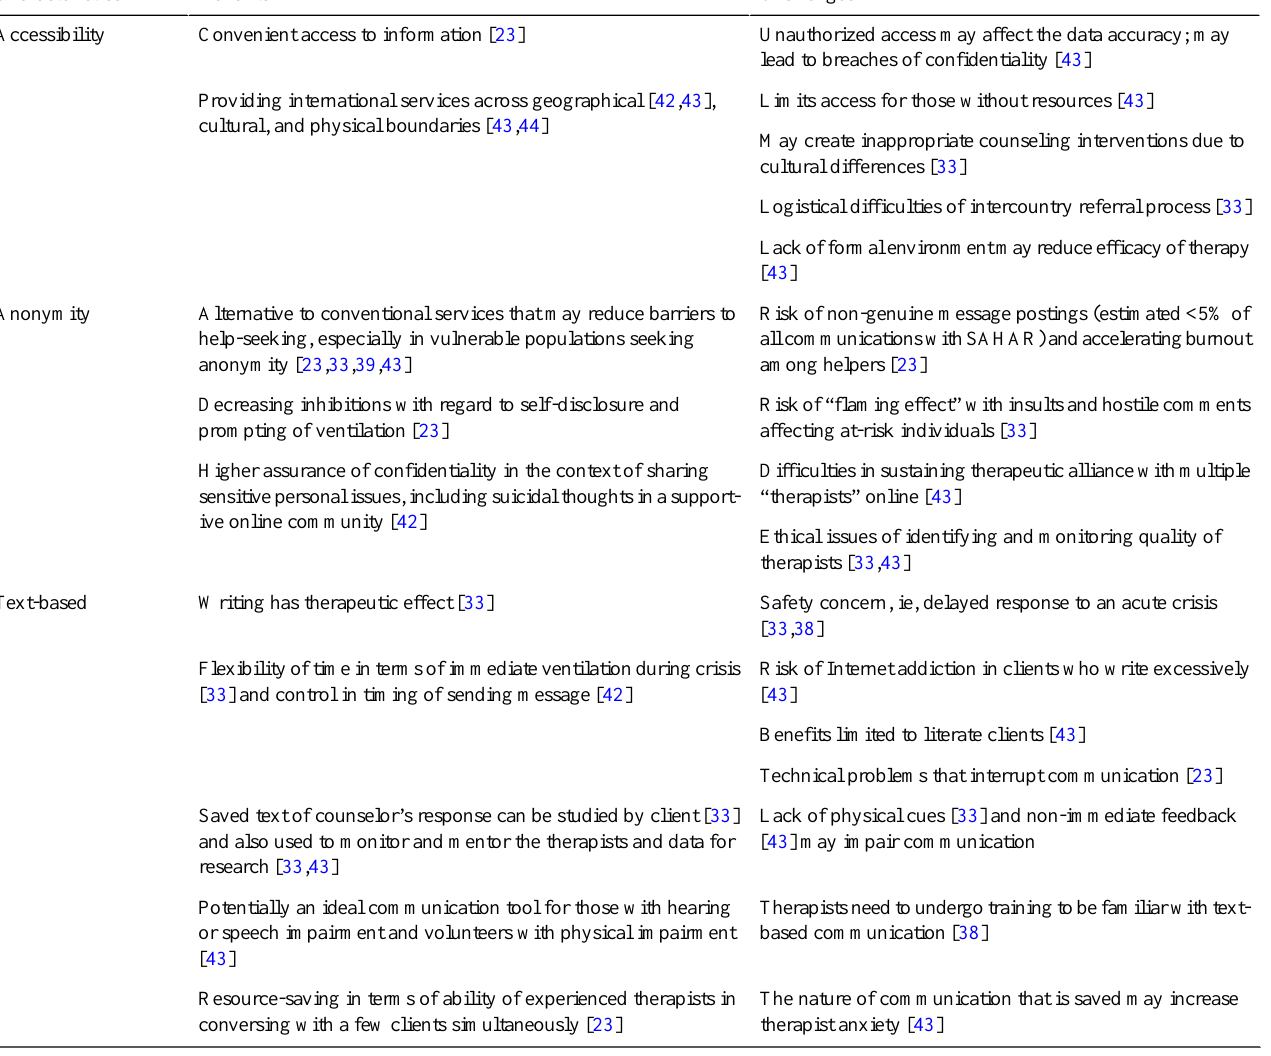
Table 1. Benefits and challenges of the main characteristics of Web-based suicide prevention programs.